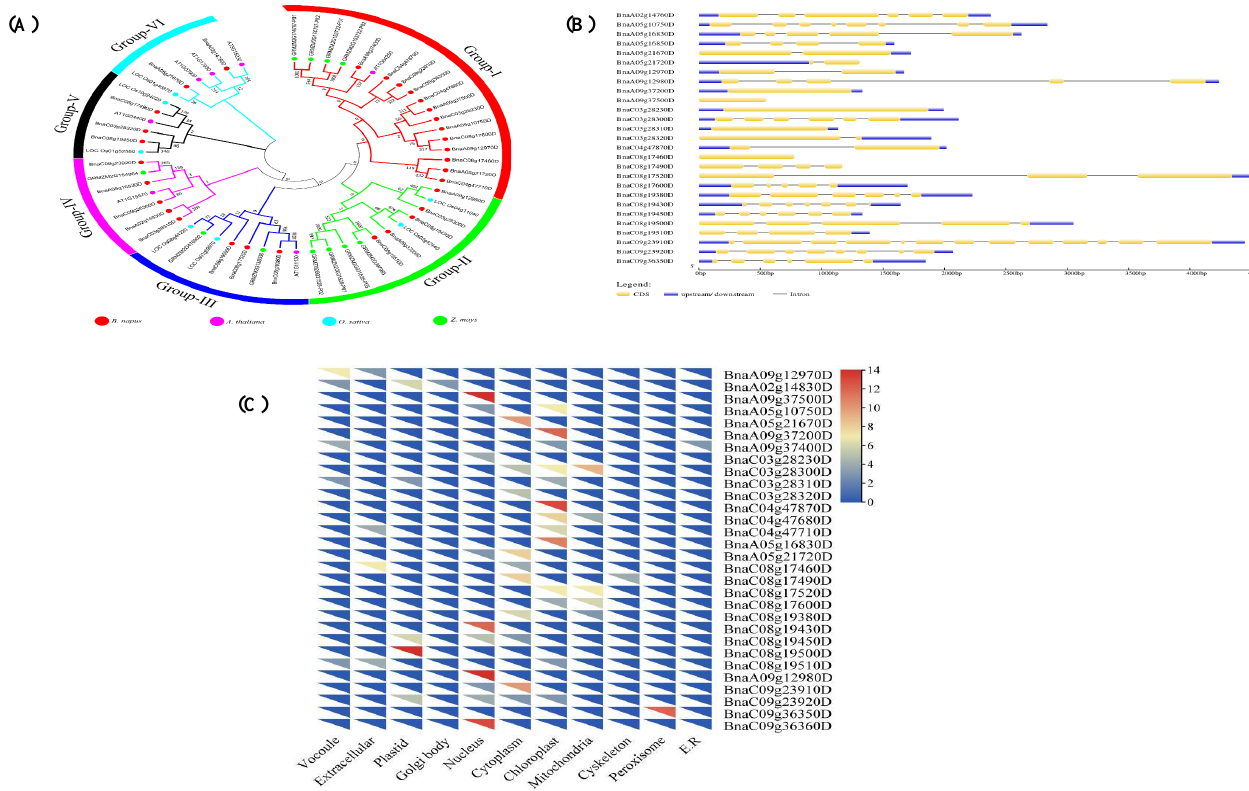
Figure 4. Phylogenetic tree analysis, gene structure, and subcellular localization of the B. napus candidate genes ( A ) Phylogenetic tree and subgroup representation of genes in B. napus, A. thaliana, Zea mays, and Oryza sativa . MEGA 7 software was used to construct the phylogenetic tree using the neighbor-joining method with a bootstrap value of 1000. The numbers beside the branches show the bootstrap values. ( B ) The distribution of exons and introns in the genes. ( C ) The distribution of genes throughout subcellular organelles. The red and yellow hue shows the density of the gene in the